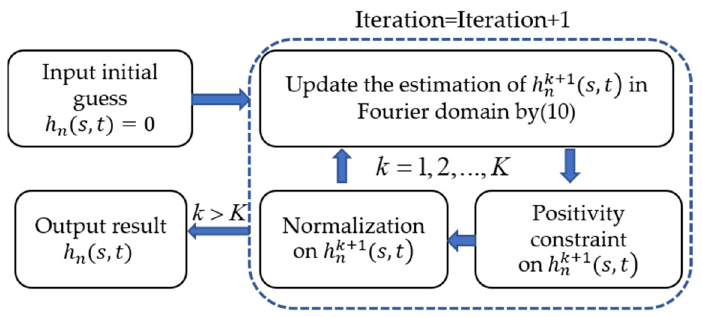
Figure 3. The algorithm flow chart of the local aberration recovery process.